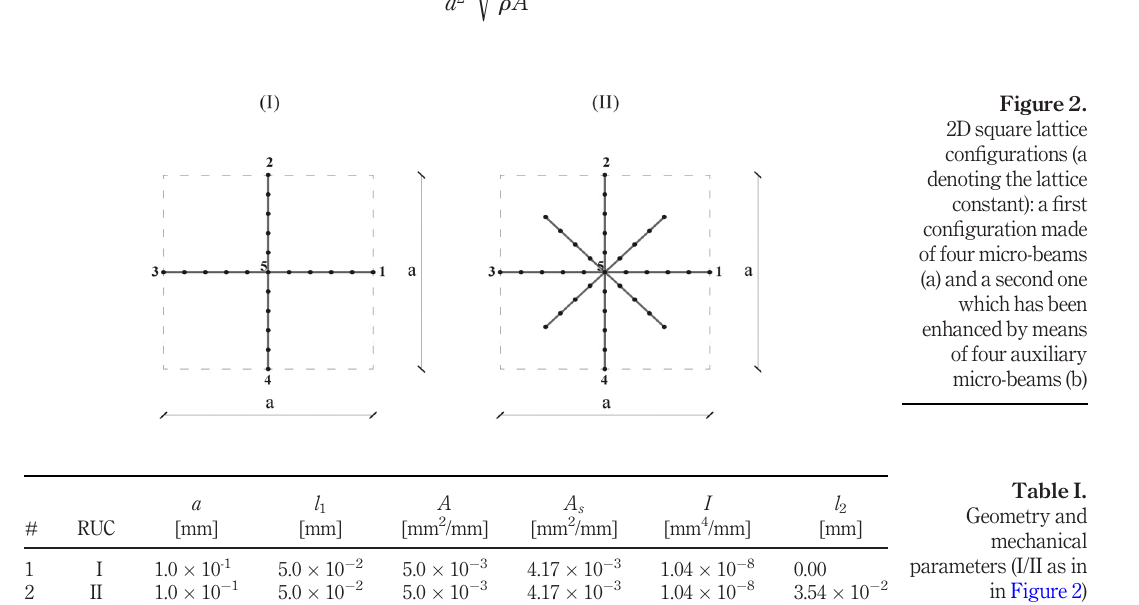
Figure 2. 2D square